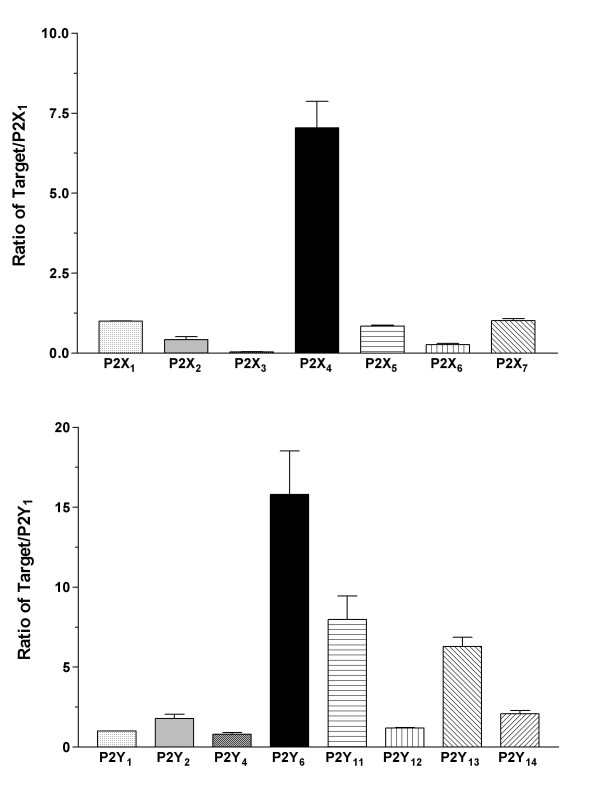
Relative expression of P2 receptors in PBMCs. The relative expression of the P2X receptor gene (upper) and P2Y receptor gene (lower) in PBMCs are presented (n = 4). The expression was normalized to GAPDH. P2X receptors were calibrated by P2X1 and P2Y receptors were calibrated by P2Y1. Data are the mean ± SEM.